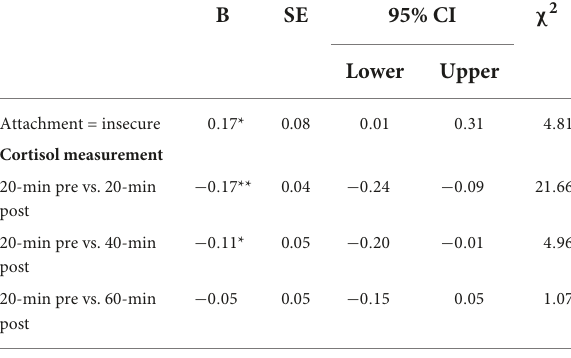
TABLE 3 GEE model of cortisol response before and after the Strange Situation